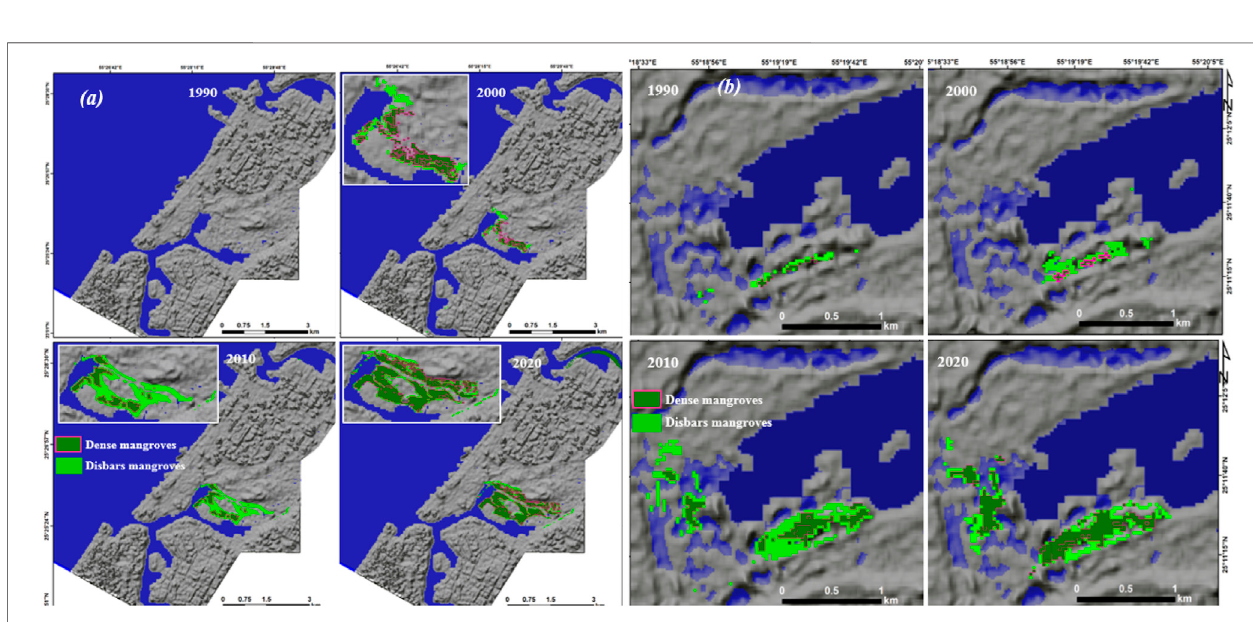
Frontiers in Remote Sensing |